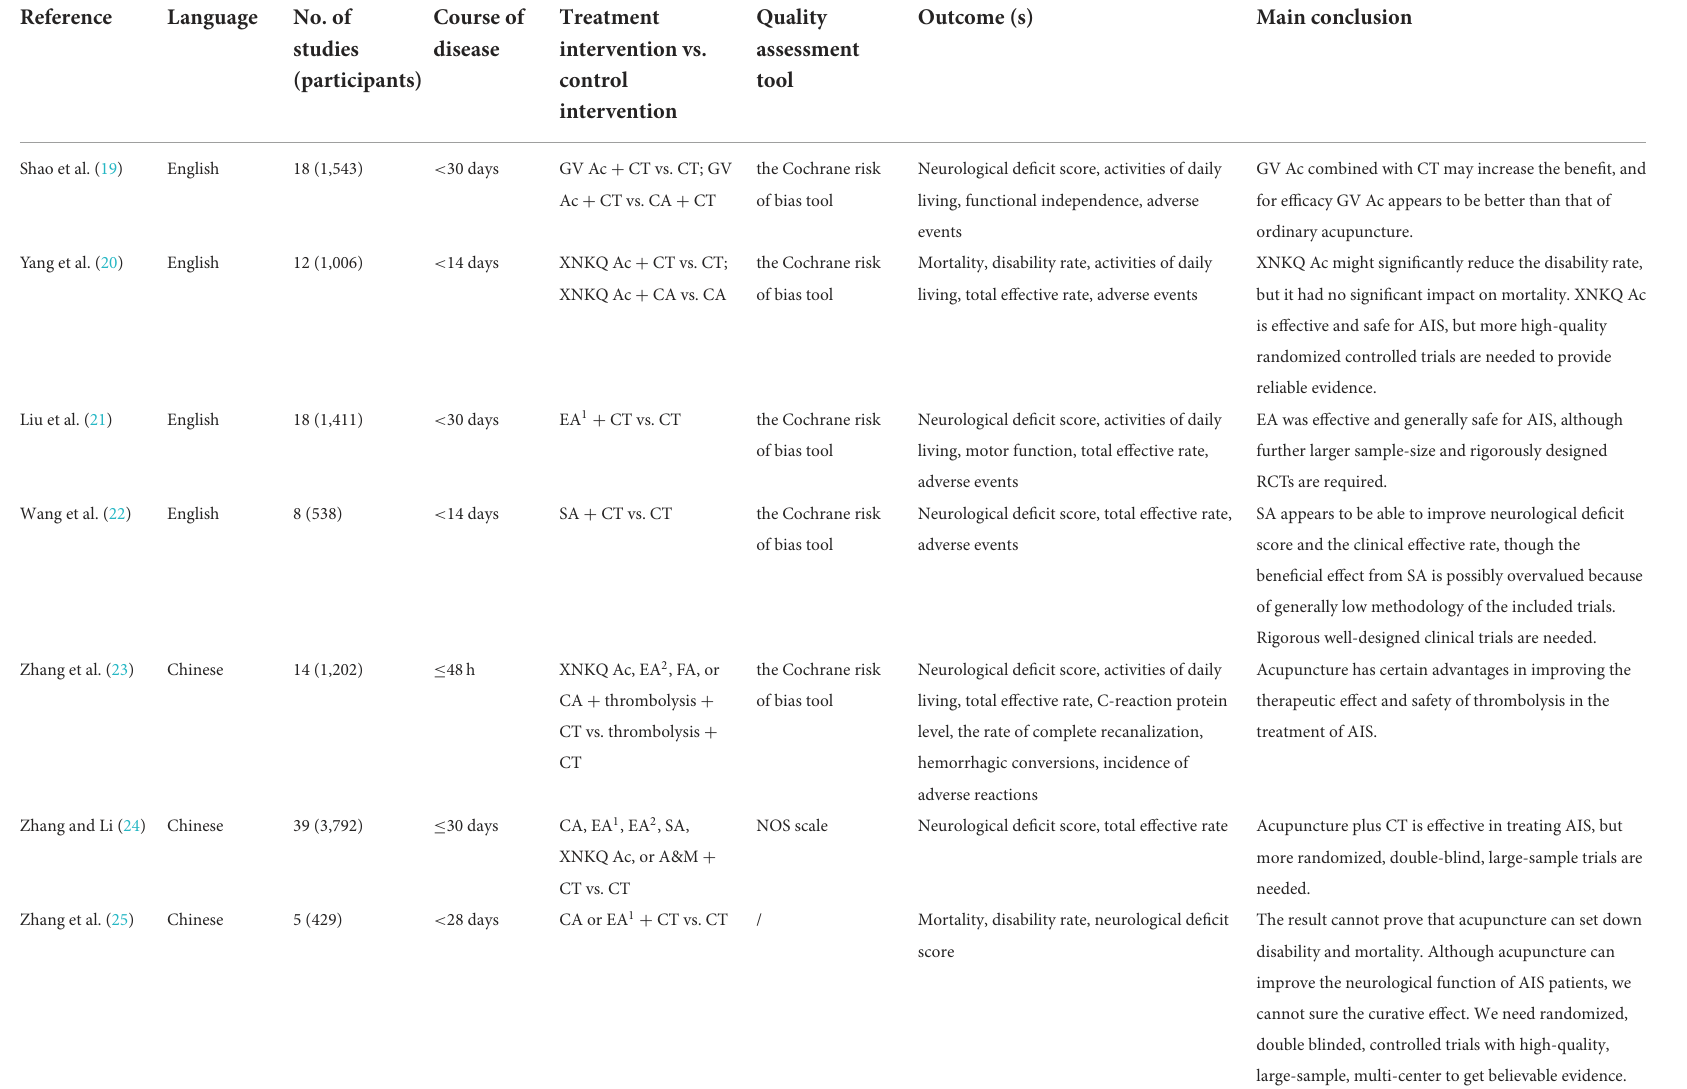
TABLE 1 Characteristics of included